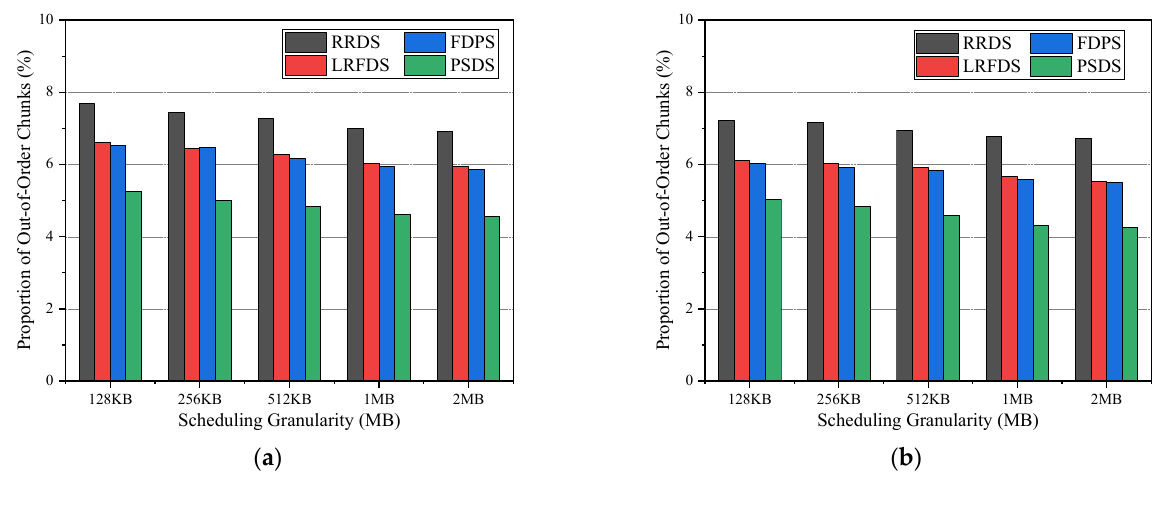
Figure 13. Proportion of out-of-order chunks under different scheduling granularities: ( a ) BT North America; ( b ) GEANT.